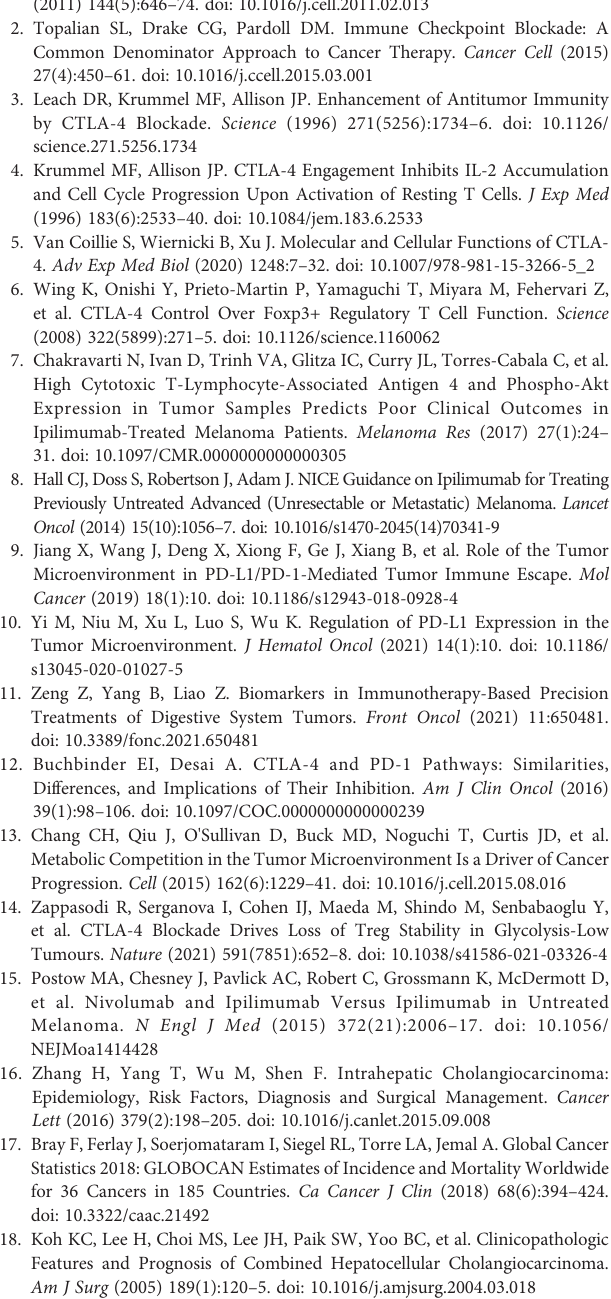
Supplementary Figure 3 | FOXP3 expression level in ICC patients with different characteristics. (A) Density of CTLA-4 + tumor in fi ltrating lymphocytes